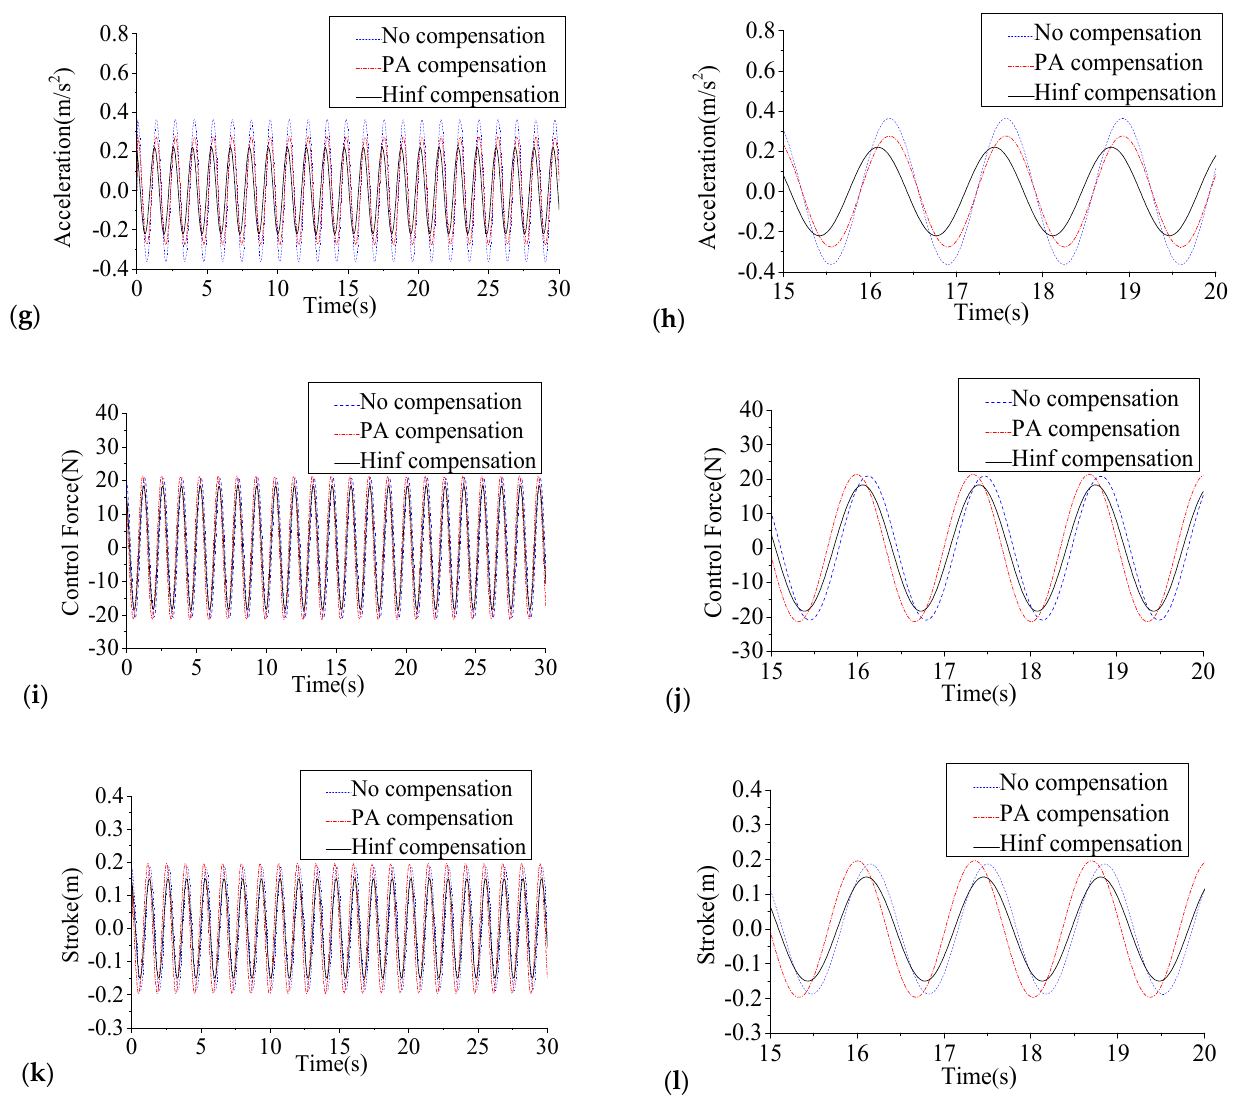
Figure 11. The structural responses and the control parameters of the experiment under the numerical results, the displacements ( a ) 0–30 s and ( b ) 15–20 s and the accelerations ( c ) 0–30 s and ( d ) 15–20 s of the 2nd floor, the displacements ( e ) 0–30 s and ( f ) 15–20 s and the accelerations ( g ) 0–30 s and ( h ) 15–20 s of the 4th floor, the forces ( i ) 0–30 s and ( j ) 15–20 s and the strokes ( k ) 0–30 s and ( l ) 15–20 s.